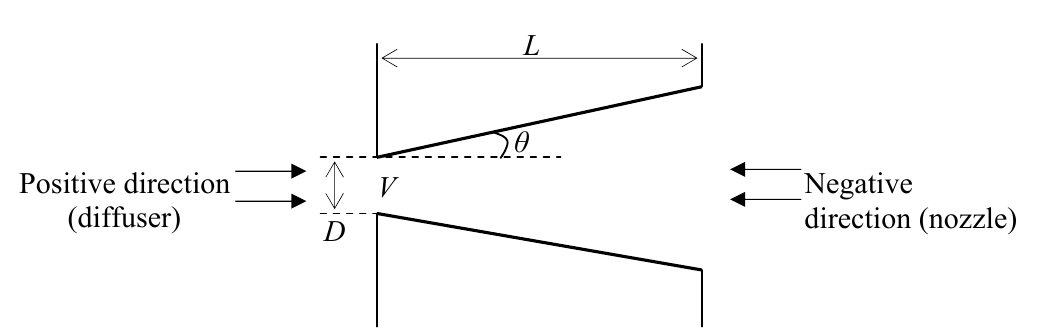
Figure 2. Fluid flow in a diffuser